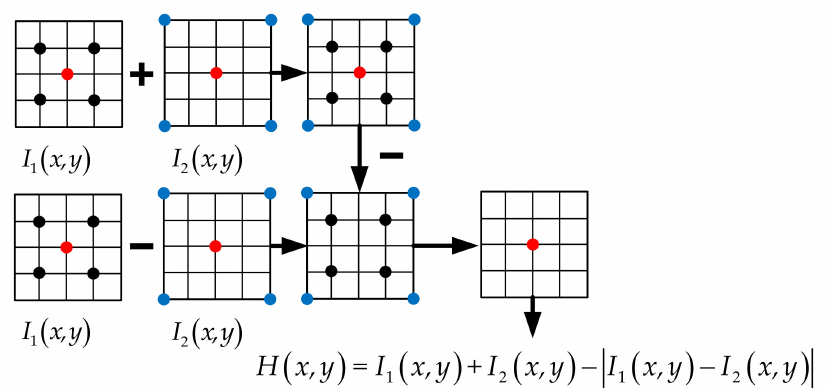
Figure 7. Flowchart of spatial location identification function for true and false